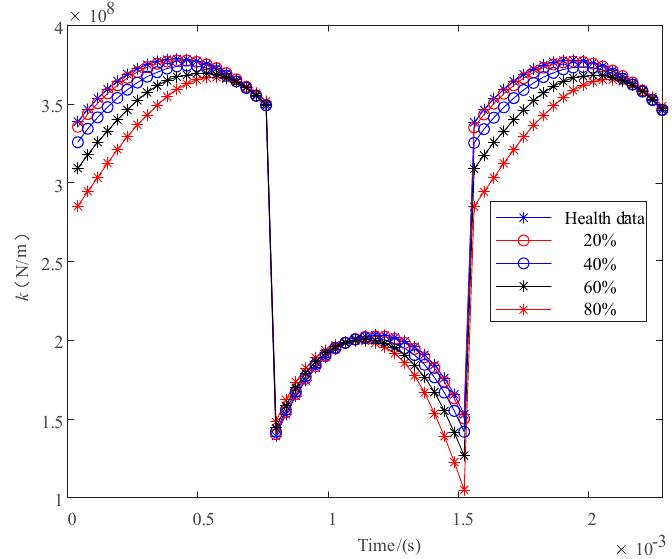
Figure 11. TVMS of single tooth under different fault degrees.